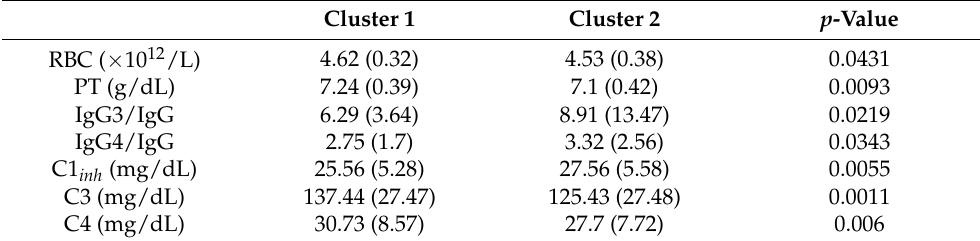
Table 6. Blood analytic differences between C1q case clusters. Group means and standard deviations are shown. Cluster 1 Cluster 2 p